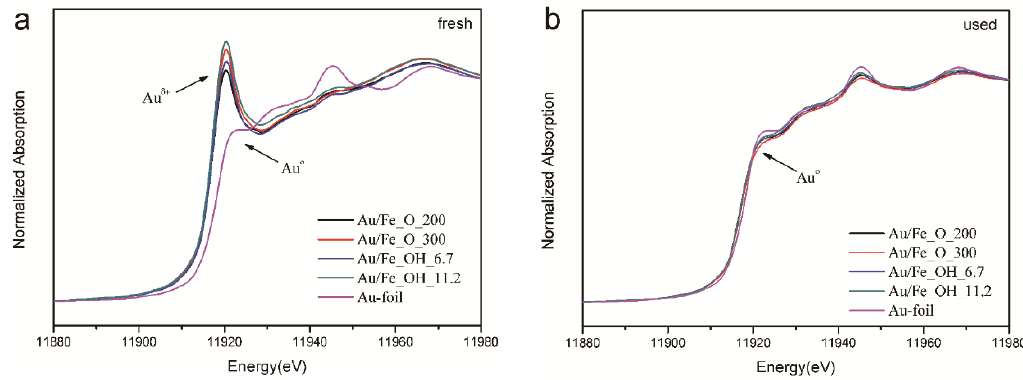
Figure 8. XANES profiles of Au L3 edge for Au/FeO x catalysts: ( a ) fresh and ( b ) used.